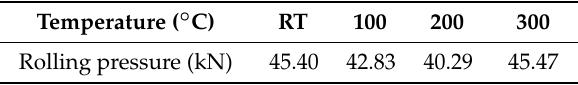
Table 3. Rolling force values at different rolling